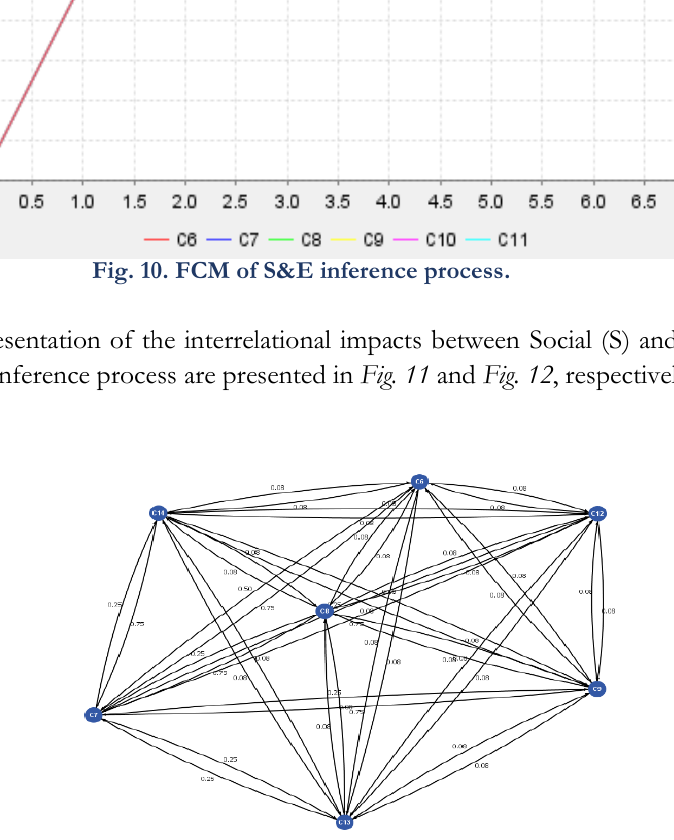
Fig. 11. Graphical representation of S&H factors of FCM.